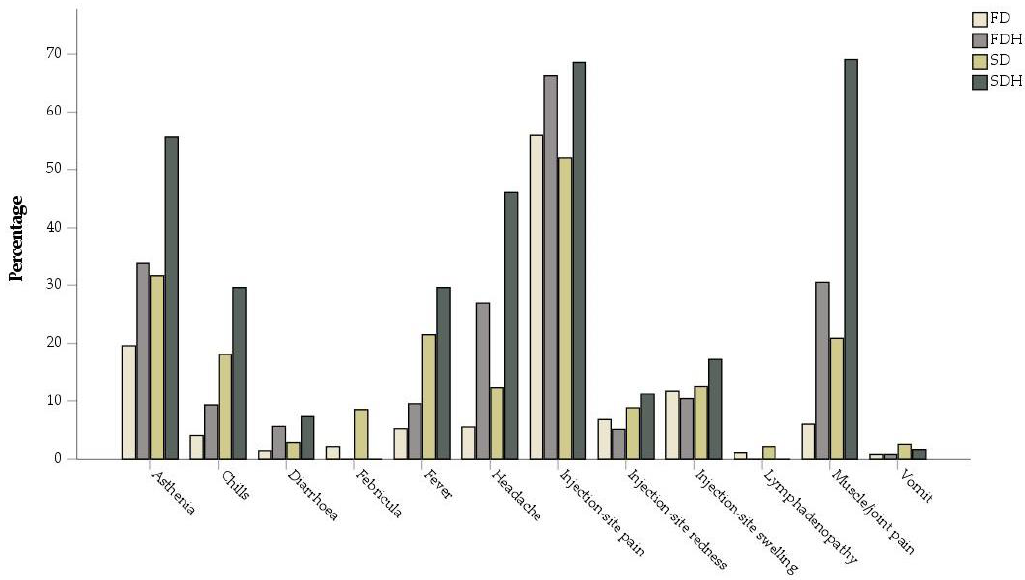
Figure 1. Comparison between percentages of adverse events in our study’s population and Rosen- blum et al.’s population on healthy individuals [13]. FD = first dose ( n = 377); SD = second dose ( n = 354); FDH = first dose on healthy individuals ( n = 5,674,420), SDH = second dose on healthy individuals ( n = 6,775,515).